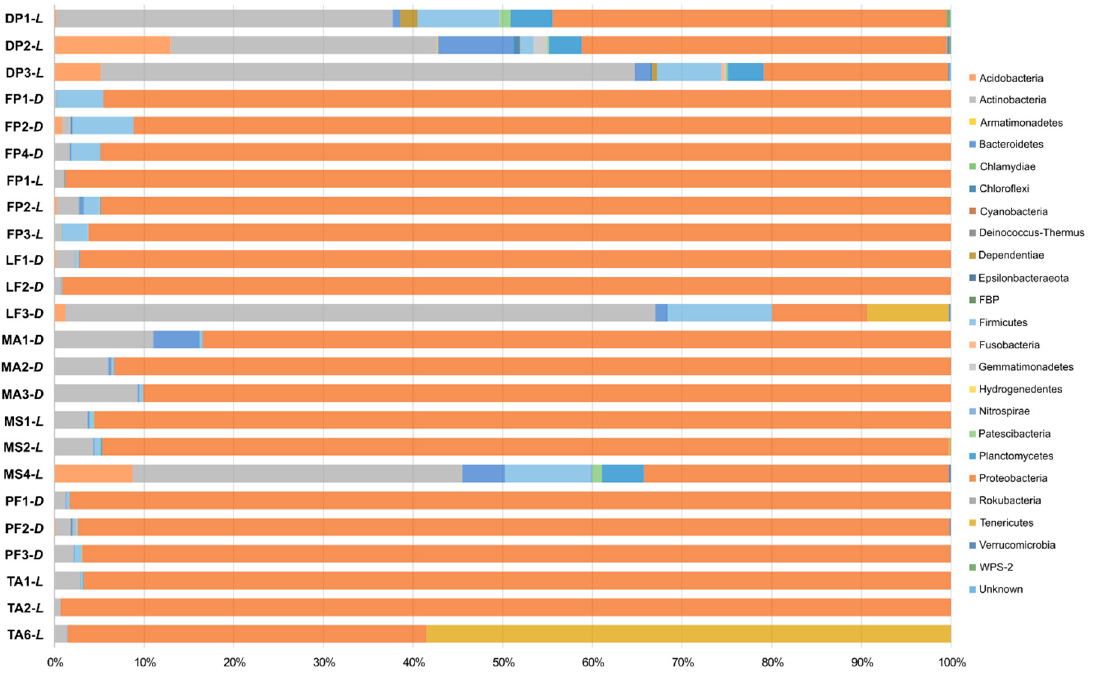
Figure 1. Abundance of bacterial 16S rRNA gene sequences at the phylum level.